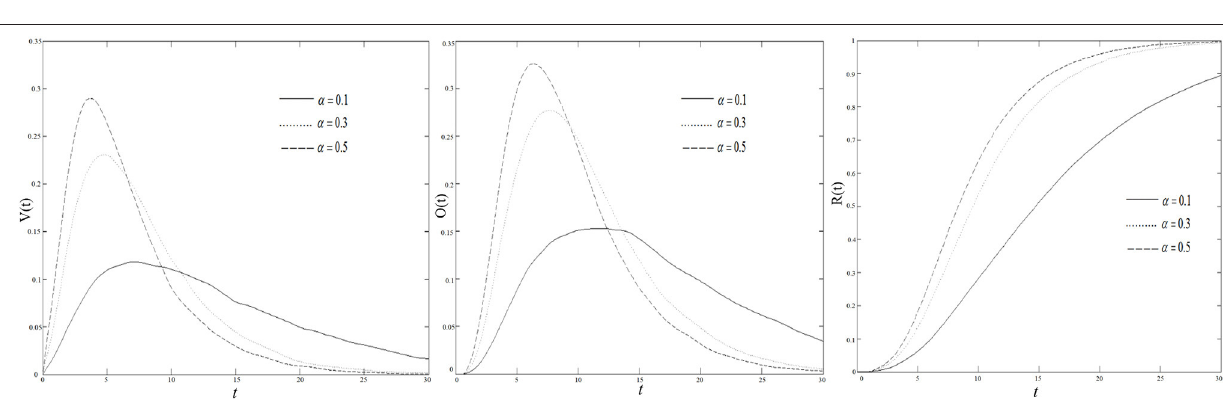
FIGURE 10 | The differences of the oyster density in WS small world and BA scale-free network when ξ 2 changes. (A) WS, (B) BA.